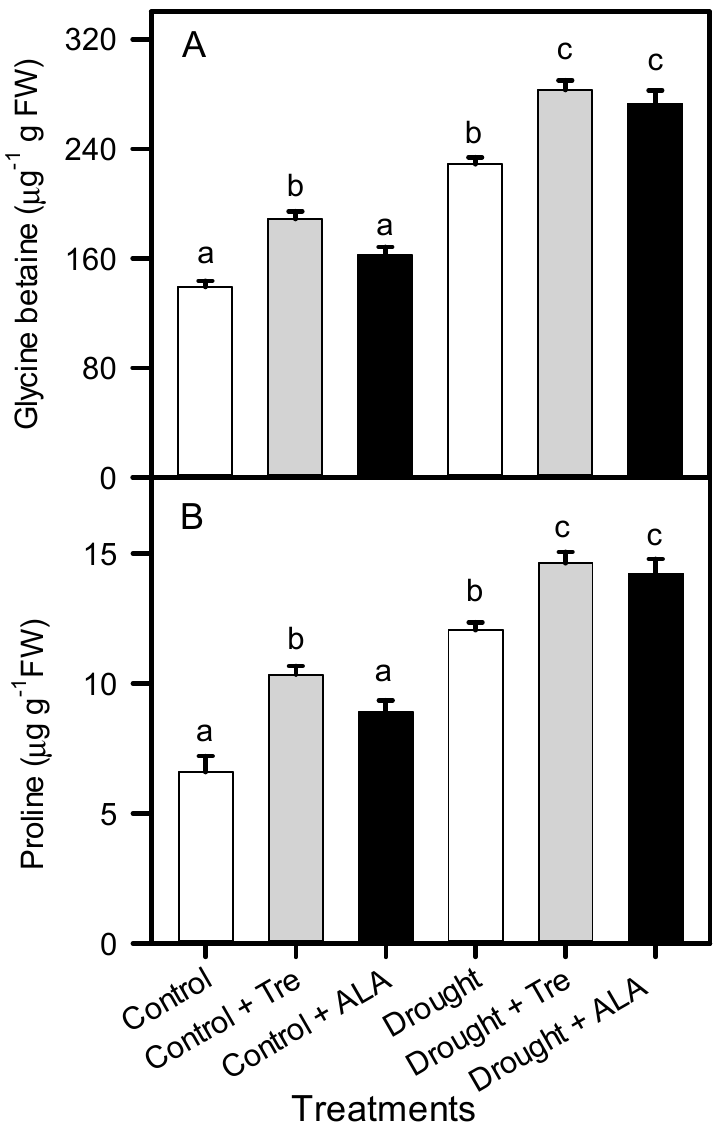
Figure 5. Leaf glycine betaine ( A ) and proline ( B ) concentrations in well-watered (100% FC, Control) and drought-stressed (65% FC, Drought) Alpinia zerumbet treated with foliar applications of water alone, 25 mM trehalose (Tre) or 10 mg L − 1 5-aminolevulinic acid (ALA). Values are means ± S.E. ( n = 6). Different letters above the bars indicate significant differences based on LSD analysis at p < 0.05.